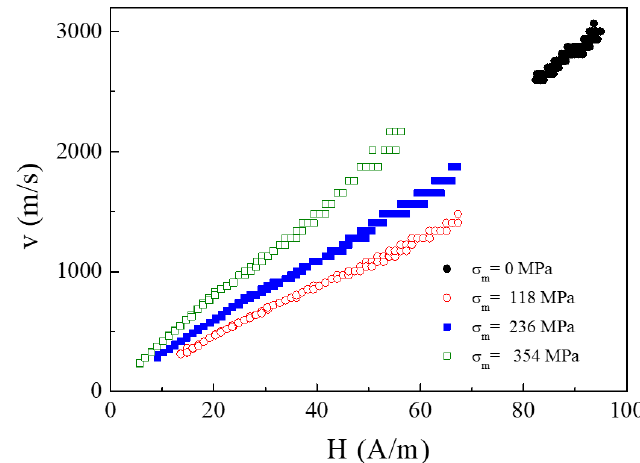
Figure 8. Velocity of DW on axial filed in the presence of different values of the stress applied during annealing. Reprinted with permission from [5].